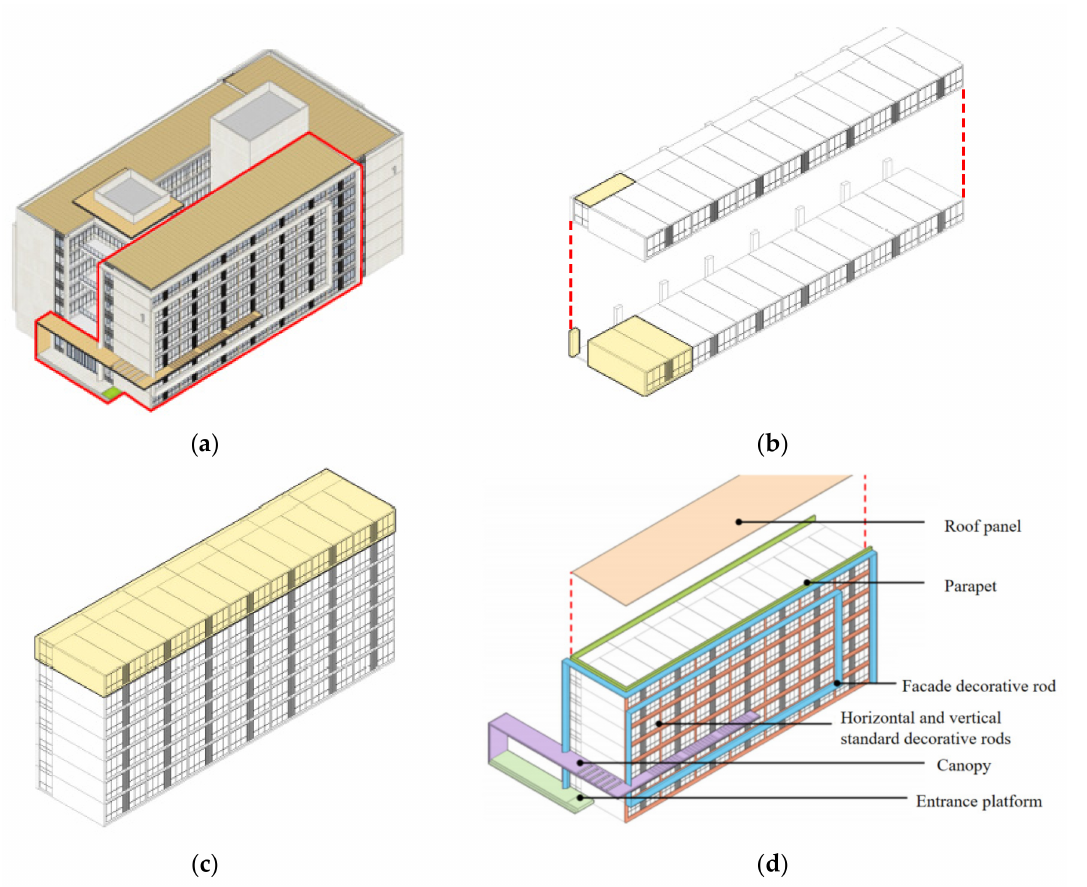
Figure 4. Vertical task resolution: ( a ) Resolution range; ( b ) Vertical transportation of MiC modules; ( c ) Site hoisting of seven-storey building; ( d ) Installation of facade decorative components.